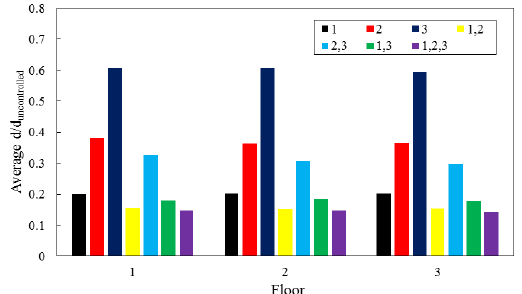
Figure 8. Comparing controlled and uncontrolled acceleration at different floors for different dampers’ arrangements under Kern Country